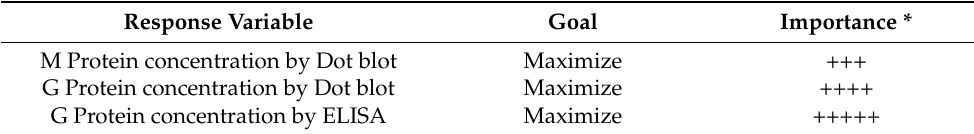
Table 2. Criteria implemented in Derringer and Suich’s desirability function (Design Expert ® version 13 software) for rabies VLP production optimization in co-infections blocks 1, 2, and 3 (Table